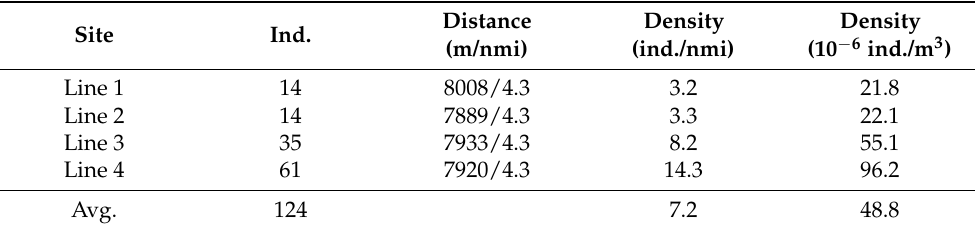
Table 11. Distribution density of jellyfish using the sighting survey method in the Gijang coastal waters sea (7/21). Site